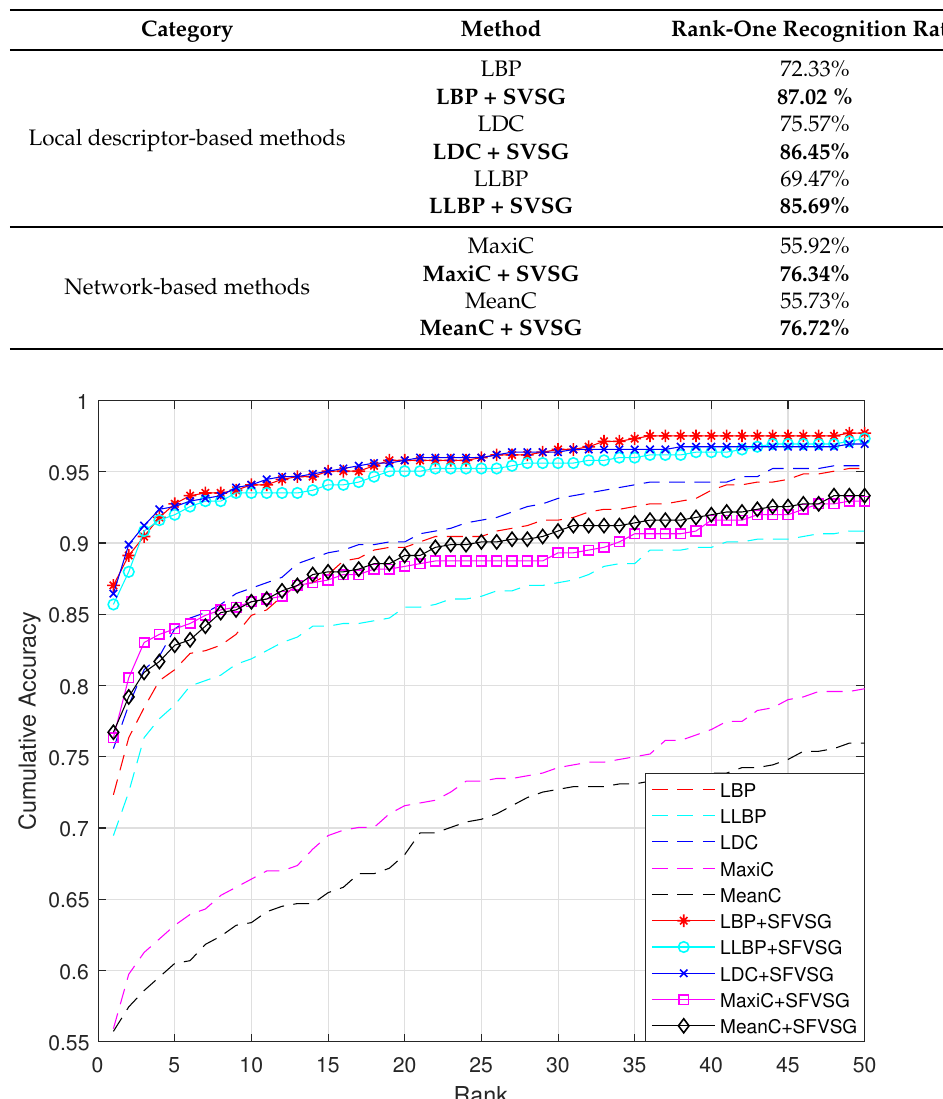
Table 1. Identification performance of different methods.